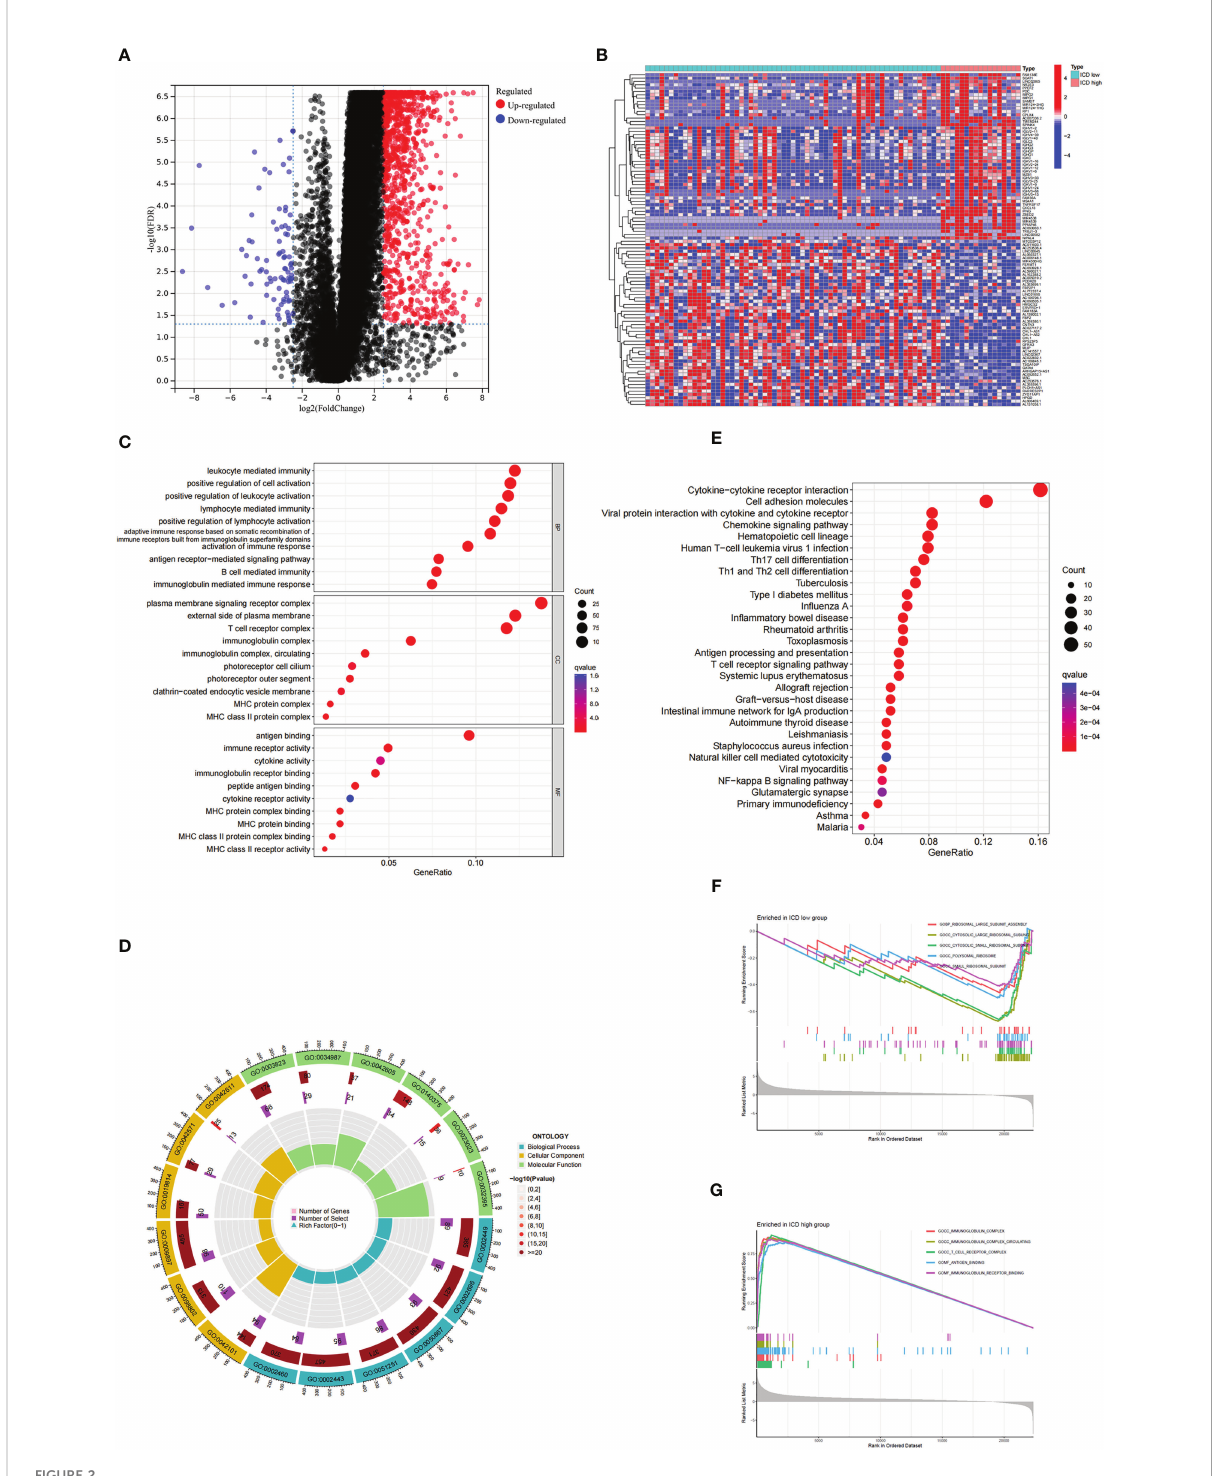
FIGURE 2 Analysis of the DEGs and functional enrichment analysis in different ICD clusters. (A) Volcano plot displays the DEGs between the high and low ICD expression groups in the TCGA cohort. (B) Heatmap of the DEGs expression between the high and low ICD expression groups. (C, D) The dots (C) and circle plots (D) of GO signaling pathway enrichment analysis. (E) The dots plot of KEGG signaling pathway enrichment analysis. The size of the dot represents gene count, and the color of the dot represents the q value. (F, G) GSEA analysis shows the underlying signal pathway between the low (F) and high (G) ICD expression groups. The top 5 signaling pathways were shown on the